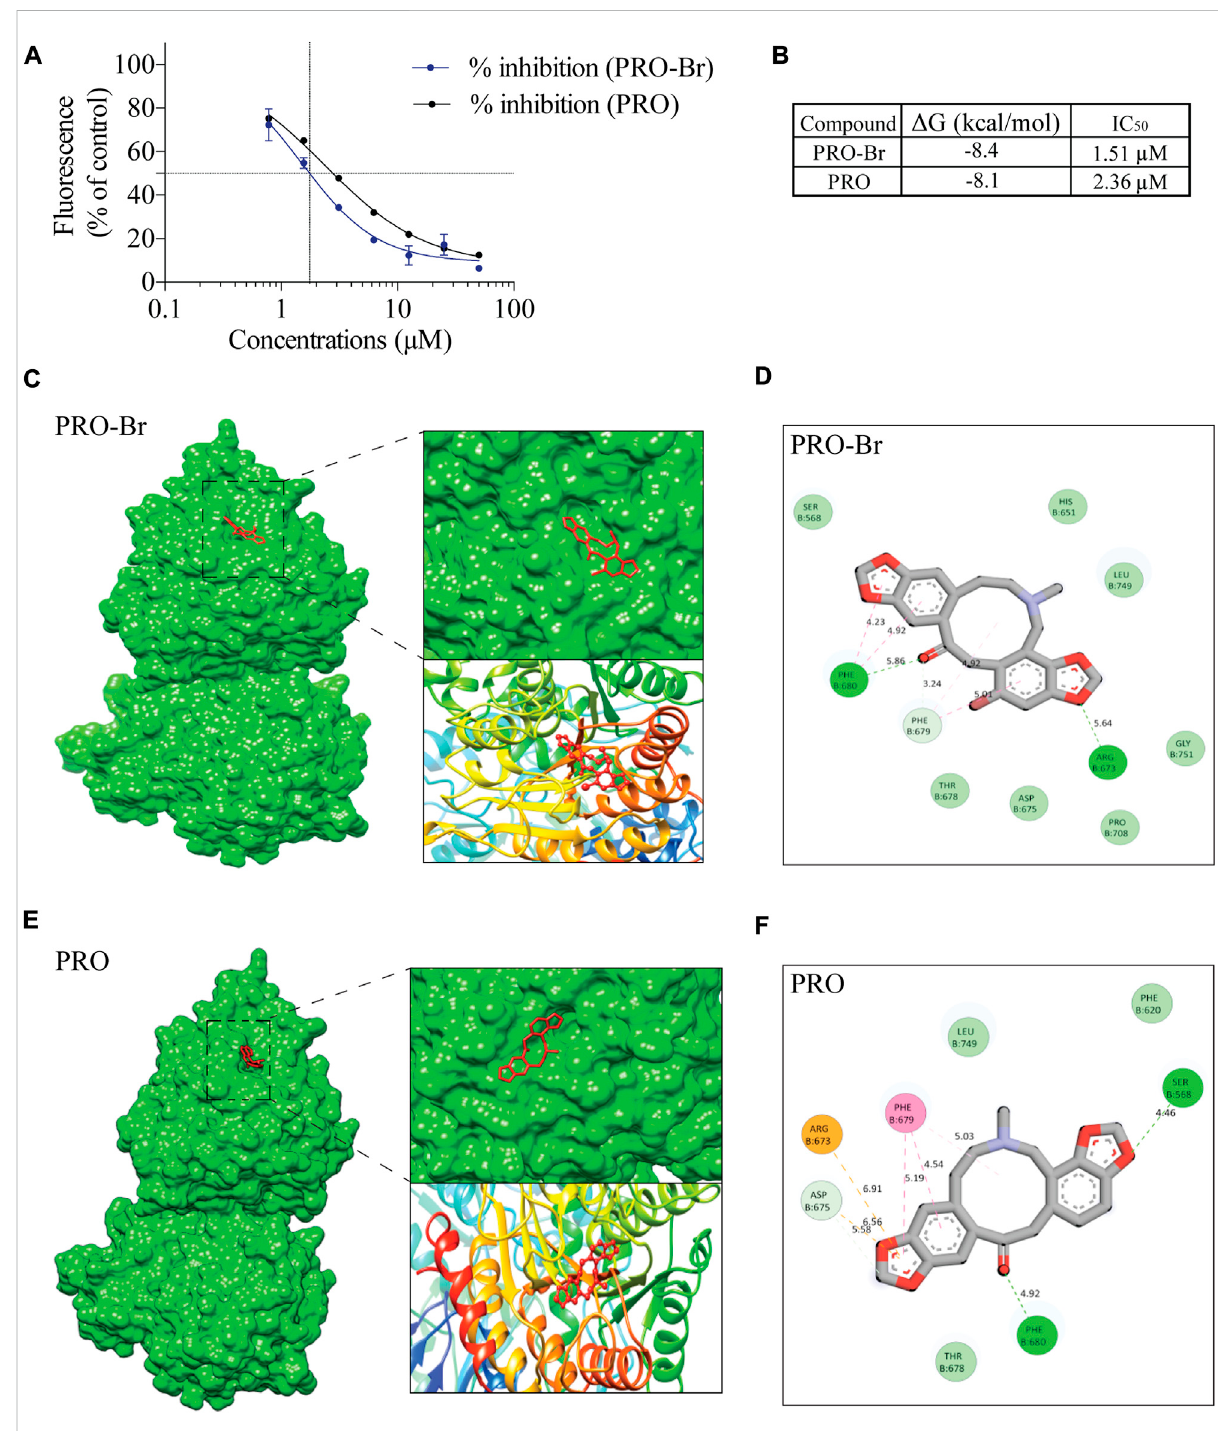
FIGURE 5 PRO-Br speci fi cally binds to HDAC6 (A) PRO-Br/PRO can dose-dependently inhibit the activity of HDAC6. (B) Table shows the 50% inhibitory concentration (IC 50 ) values of PRO-Br and PRO. Estimated free energies values of PRO-Br/PRO are as shown in table. (C – F) Visualization of the binding and key interacting amino acids between PRO-Br/PRO and